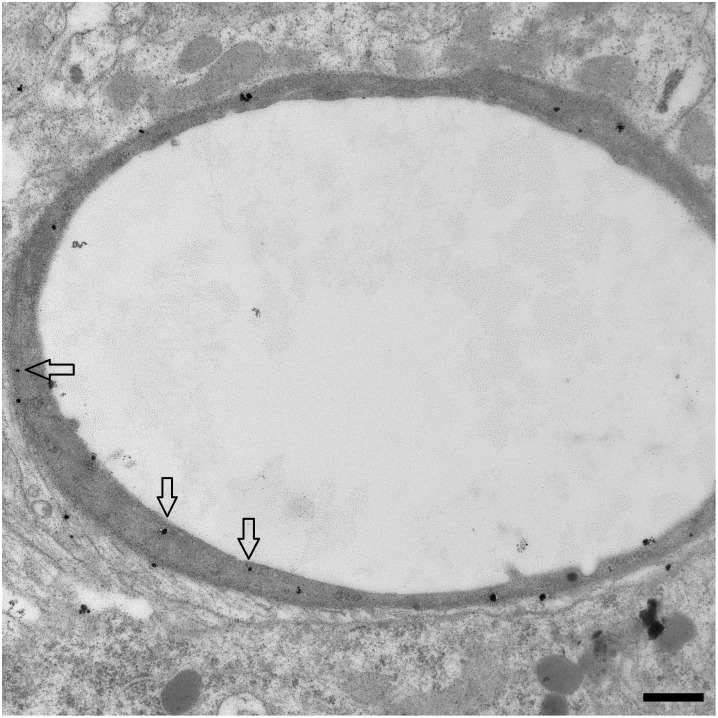
Location of PEG-amine/galactose nanoparticles in a brain vessel in vivo.Silver-enhanced electron micrograph of a microvessel of rat cerebral cortex, 10 minutes after intracarotid infusion of 50 μg (Au) of nanoparticles. Arrows indicate nanoparticles in the endothelium. Scale bar = 500 nm.